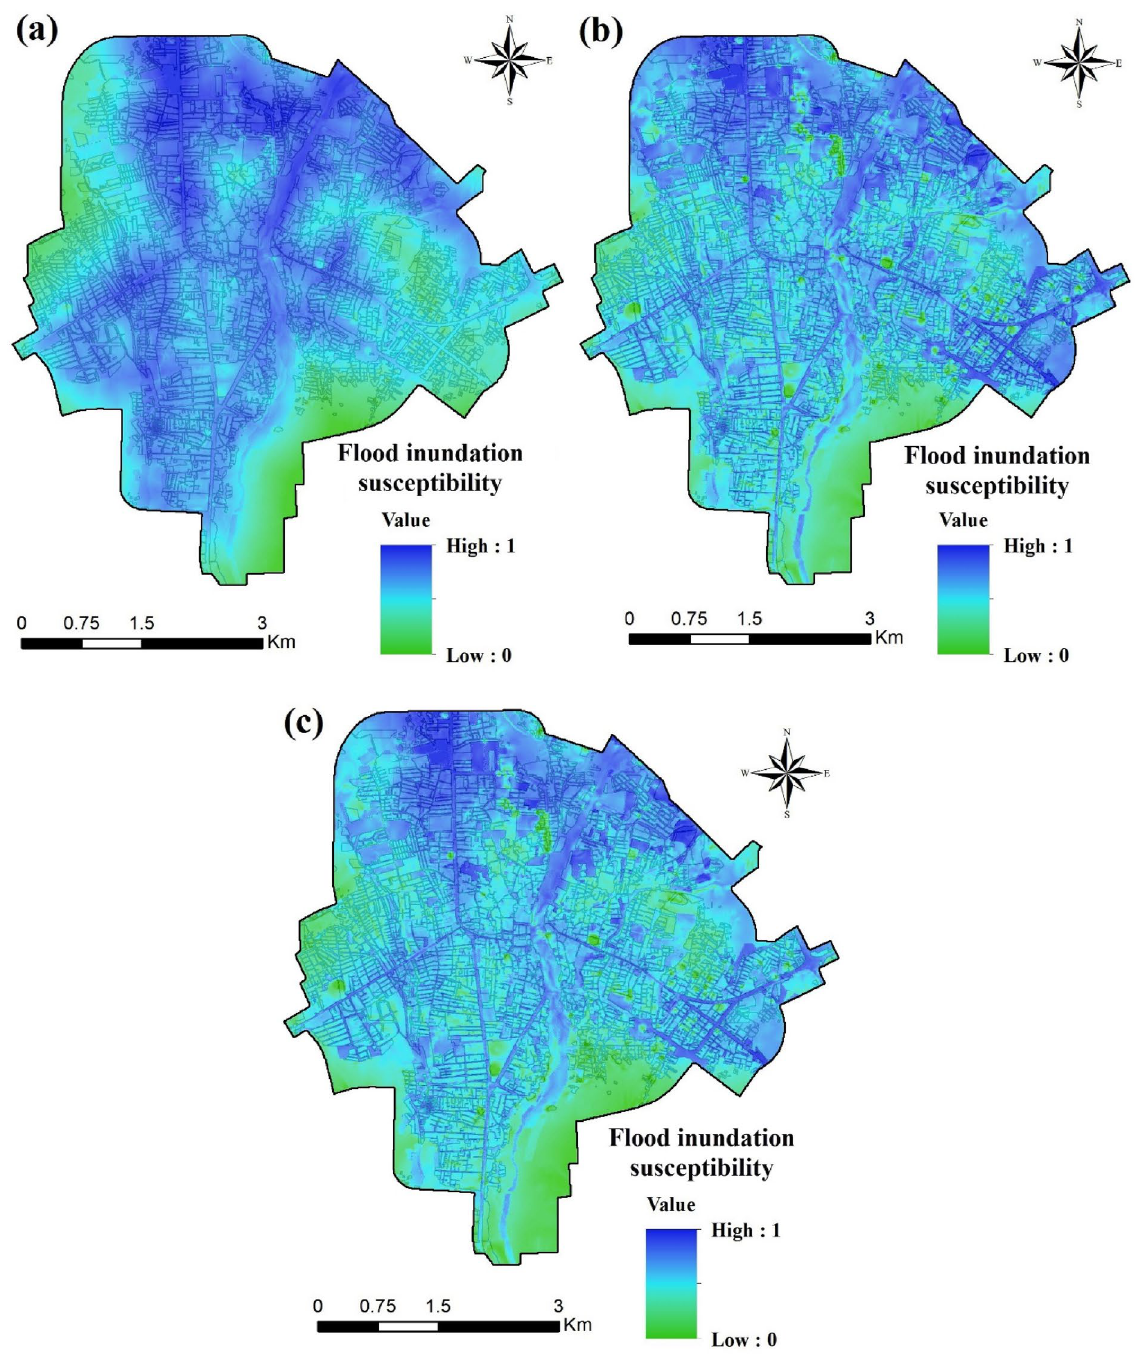
Figure 7. Flood inundation susceptibility maps for the city of Amol according to: ( a ) the SVR model, ( b ) the Wavelet-SVR-Bat model, and ( c ) the Wavelet-SVR-GWO model. These maps were generated using ArcGIS Desktop 10.7.1, https ://deskt op.arcgi s.com/en/.